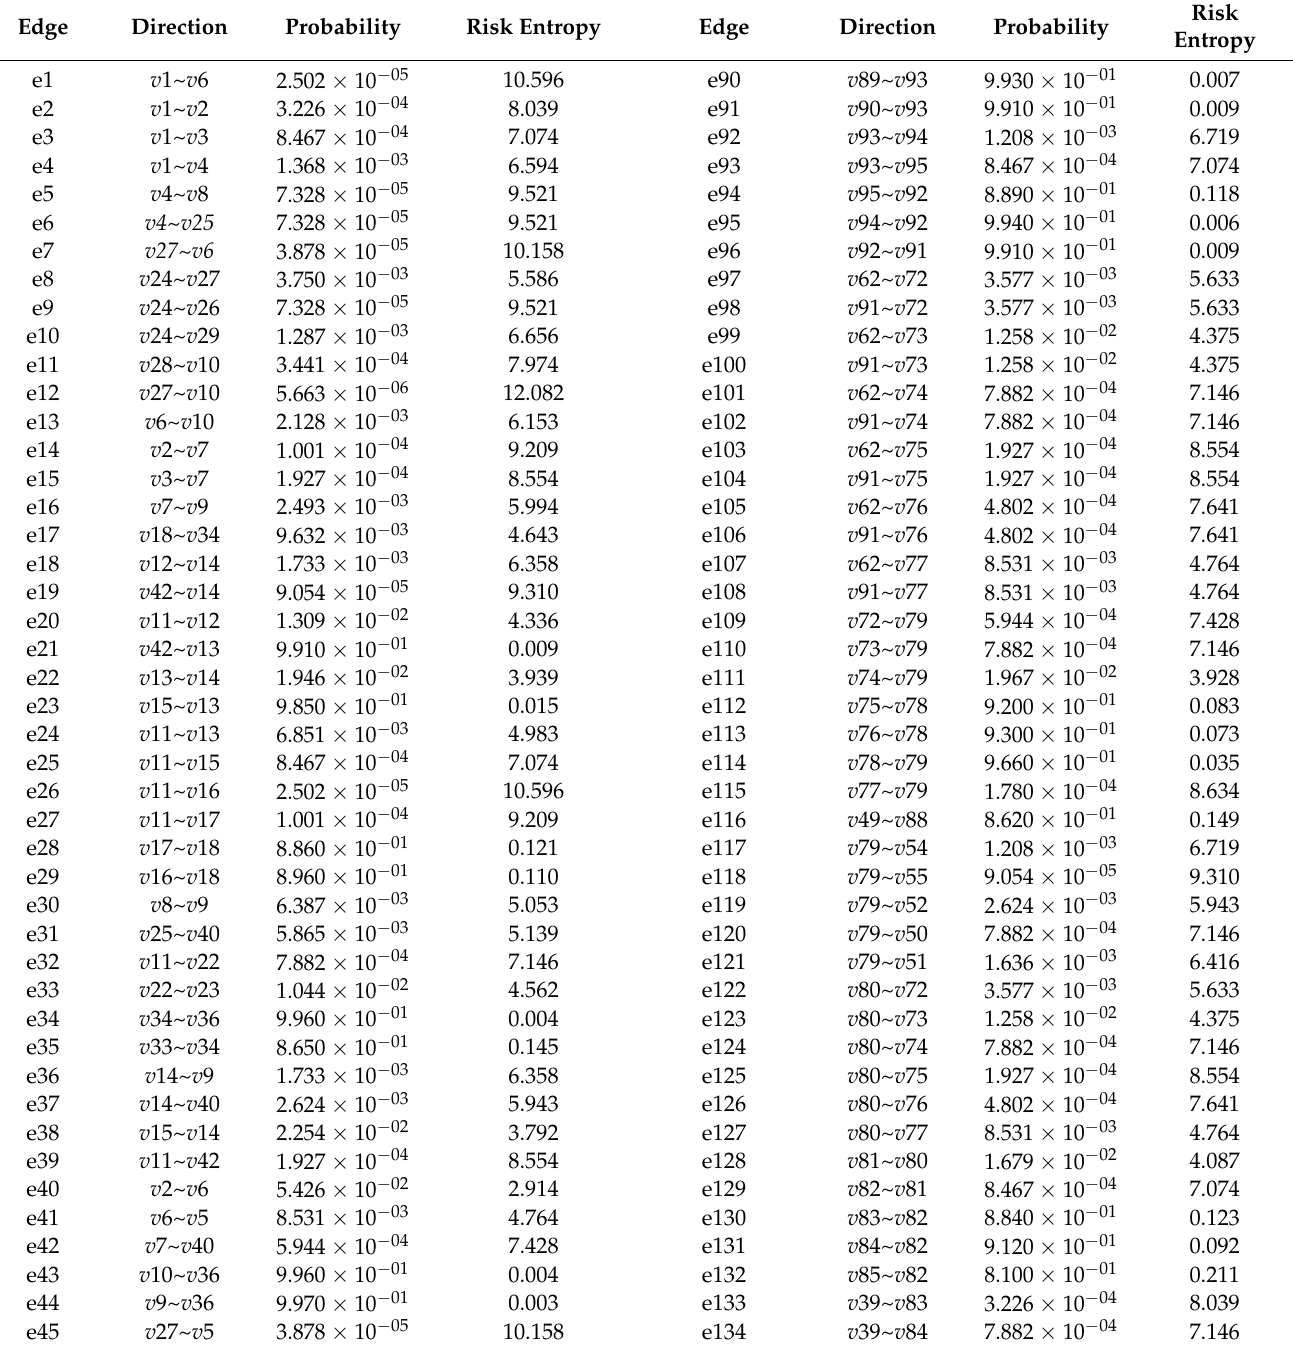
Table A1. Edge Weights of Risk Complex Evolution